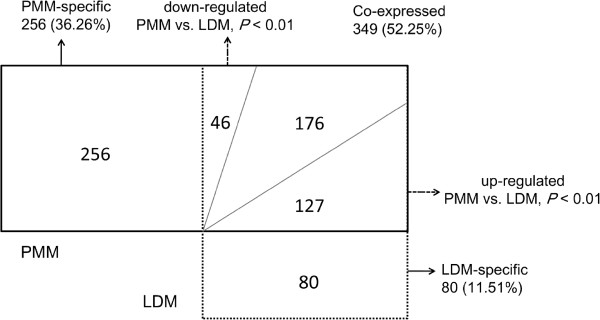
Characteristics of differentially expressed miRNAs between LDM and PMM. The diagram displays the distribution of 668 unique miRNAs between the PMM (solid line) and LDM (dash line) libraries. The dashed arrows indicate the differentially expressed unique miRNAs (P < 0.001) in PMM against LDM. The solid arrows indicate PMM- and LDM-specific miRNAs. LDM, longissimus dorsi muscle; PMM, psoas major muscle.